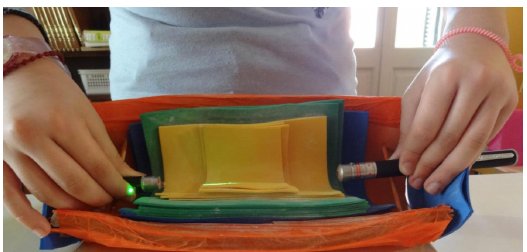
Fig. 4. The collision of the beams by K-6